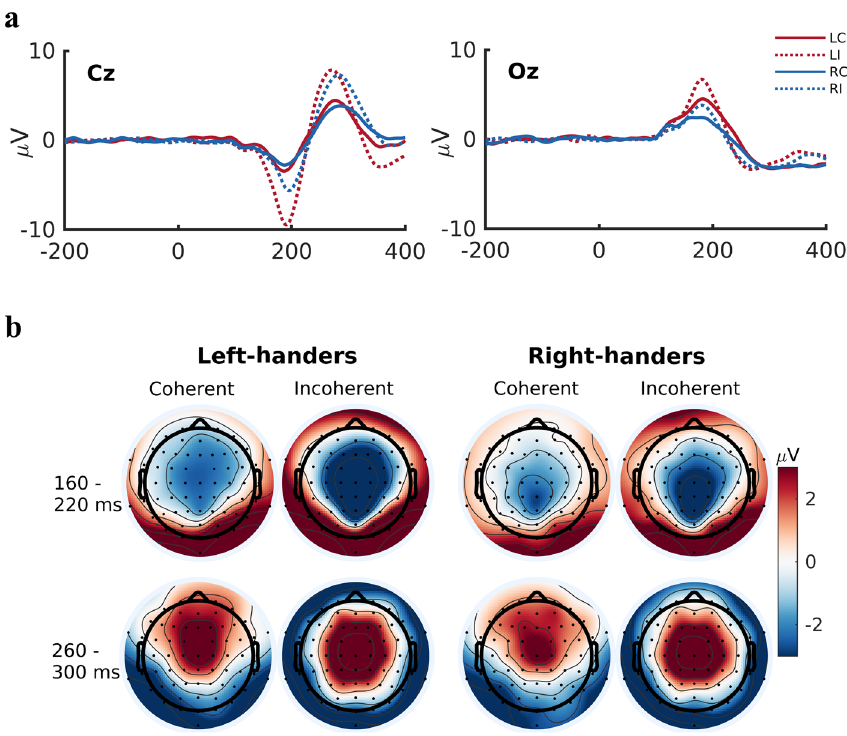
Figure 1. Overview of grand average ERP data. ( a ) The grand average ERP waveforms in example electrodes Cz and Oz. Two clear peaks were observed across almost all electrodes following motion onset: an early peak around 160–220 ms and a later peak around 260–300 ms. LC = left-handers coherent, LI = left-handers incoherent, RC = right-handers coherent, RI = right-handers incoherent. ( b ) Presents a topography of the mean amplitude values that were obtained in the early and late windows in the coherent and incoherent conditions, for left- and right-handers respectively. In both conditions, the early window was characterised by a pattern of fronto-central negativity (blue) and parieto-occipital positivity (red). This pattern reversed in the later window, with frontal positivity and parieto-occipital negativity in the coherent condition and a more central positivity with surrounding negativity in the incoherent condition. In general, larger amplitudes were observed in the incoherent condition and amongst the left-hander